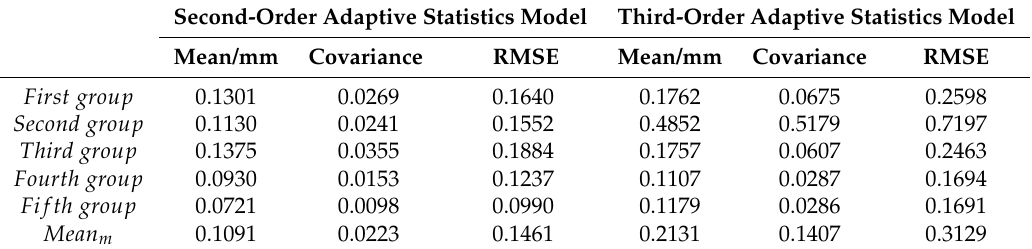
Table 1. Performance comparison between different adaptive statistics models.